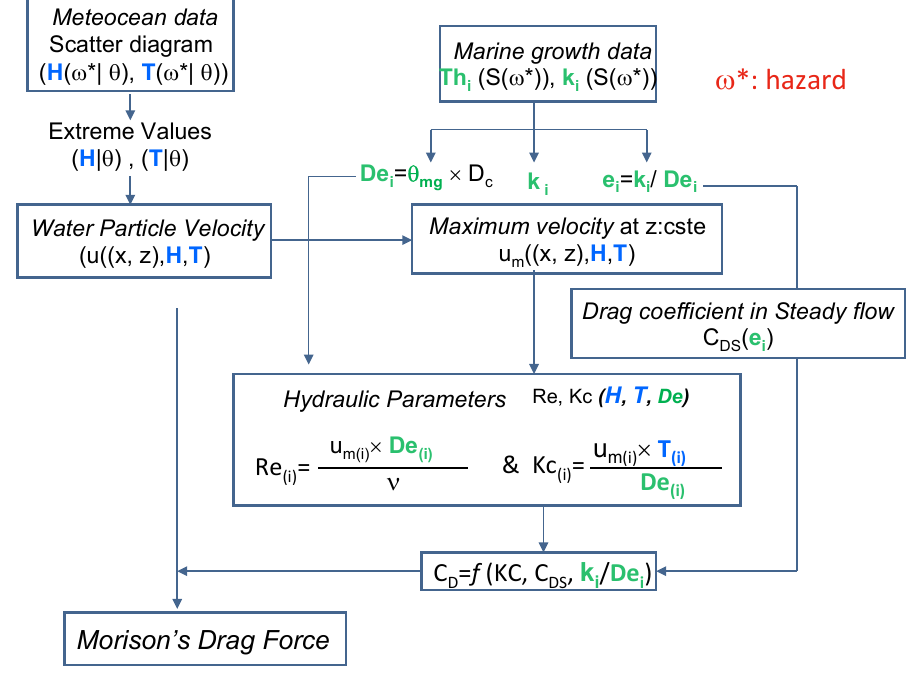
Figure 10. Schematic flowchart of drag force calculation.